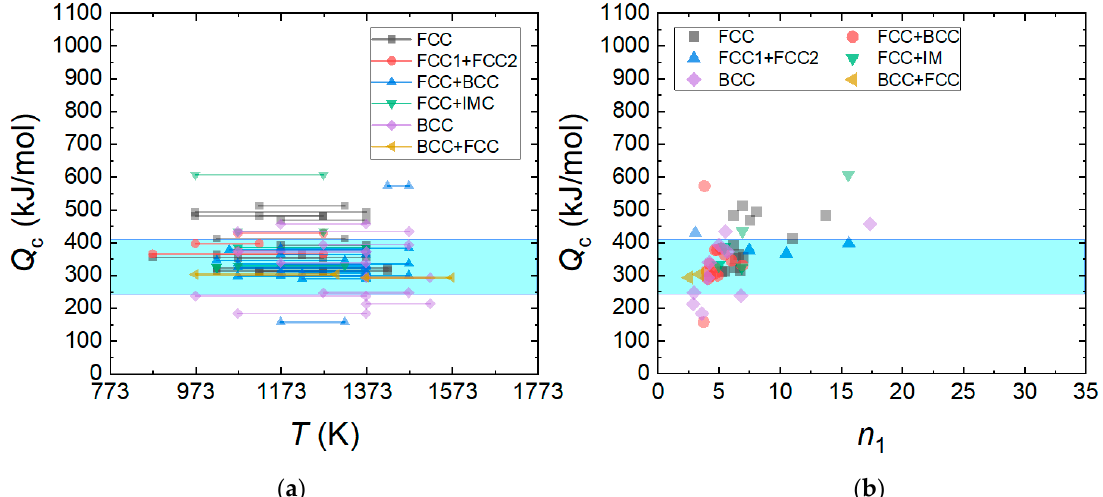
Figure 7. ( a ) Q c values of HEAs calculated using Equation (4) and ( b ) the relation between n 1 and Q c for the HEAs. The activation energy ( Q ∗ ) of tracer diffusivity of elements in the Al x CoCrFeMnNi and Al x CoCrFeNi HEAs ranges between 240 and 408 kJ/mol (shaded area by blue color): Q ∗ = 323 ± 5 kJ/mol for Cr, Q ∗ = 303 ± 3 kJ/mol for Fe, Q ∗ = 240 ± 20 kJ/mol for Co, L L L Q ∗ = 253 ± 8 kJ/mol for Ni in CrFeCoNi, Q ∗ = 313 ± 13 kJ/mol for Cr, Q ∗ = 272 ± 13 kJ/mol L L L for Mn, Q ∗ = 309 ± 11 kJ/mol for Fe, Q ∗ = 270 ± 22 kJ/mol for Co, and Q ∗ = 304 ± 9 kJ/mol L L L for Ni in CrMnFeCoNi [115]. Q ∗ = 263 kJ/mol for Al, Q ∗ = 288 kJ/mol for Cr, Q ∗ = 315 kJ/mol L L L for Fe, Q ∗ = 258 kJ/mol for Co, Q ∗ = 260 kJ/mol for Ni in Al 4.88 Co 29.53 Cr 18.58 Fe 19.62 Ni 27.39 [117], L L Q ∗ = 288 kJ/mol for Cr, Q ∗ = 408 kJ/mol for Fe, Q ∗ = 260 kJ/mol for Co, = 258 kJ/mol for Al, Q ∗ L L L L and Q ∗ = 261 kJ/mol for Ni Al 6.64 Co 23.82 Cr 23.66 Fe 23.01 Ni 22.87 L